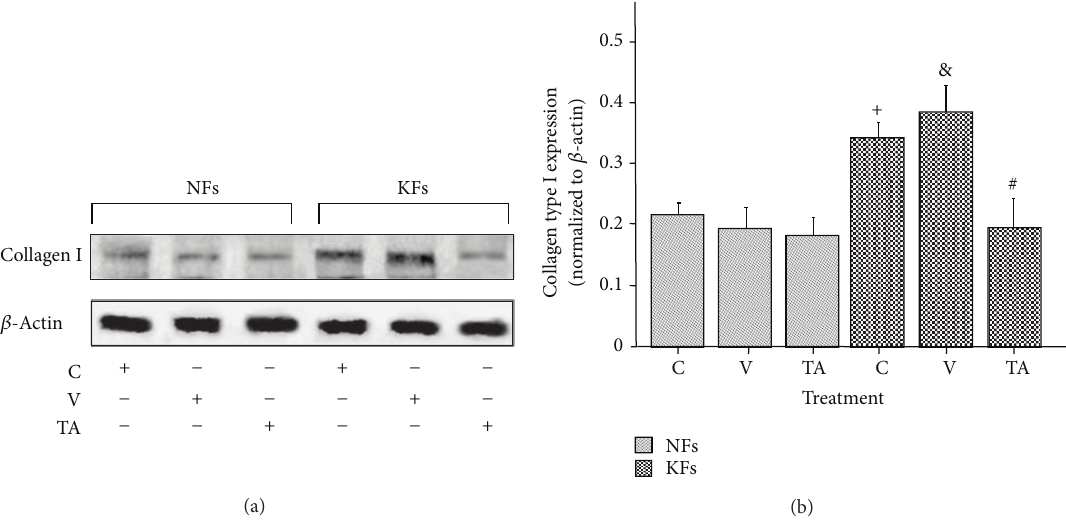
Figure 5: The effect of TA on the expression of collagen type I in NFs and KFs. DMSO slightly increased the expression of collagen type I in KFs. TA significantly inhibited the expression of collagen type I in KFs. C: control, total medium; V: vehicle, 0.55% DMSO; TA, 0.55 × 10 −3 M of TA was dissolved in 0.55% DMSO. + 𝑃 < 0.05 , C versus C; & 𝑃 < 0.05 , V versus NFs C; # 𝑃 < 0.05 , TA versus V; 𝑛 = 4 .